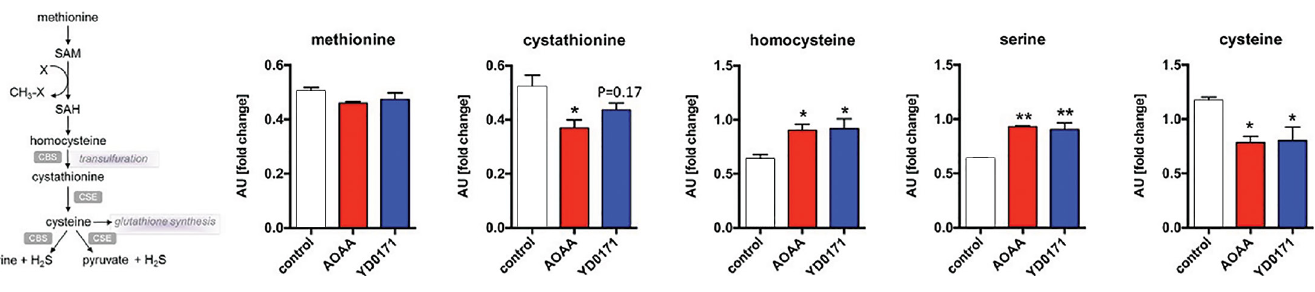
Figure 7. Effect of YD0171 on the transsulfuration pathway metabolites in HCT116 cells. Cells were treated with YD0171 (1 mmol/L) or AOAA (1 mmol/L) for 24 h, followed by metabolomic analysis. The left panel shows the relative position of the various measured metabolites in the transsulfuration pathway. * p < 0.05 and ** p < 0.01 indicate significant effect of the test compounds compared with control. Data are shown as mean ± SEM values of n =